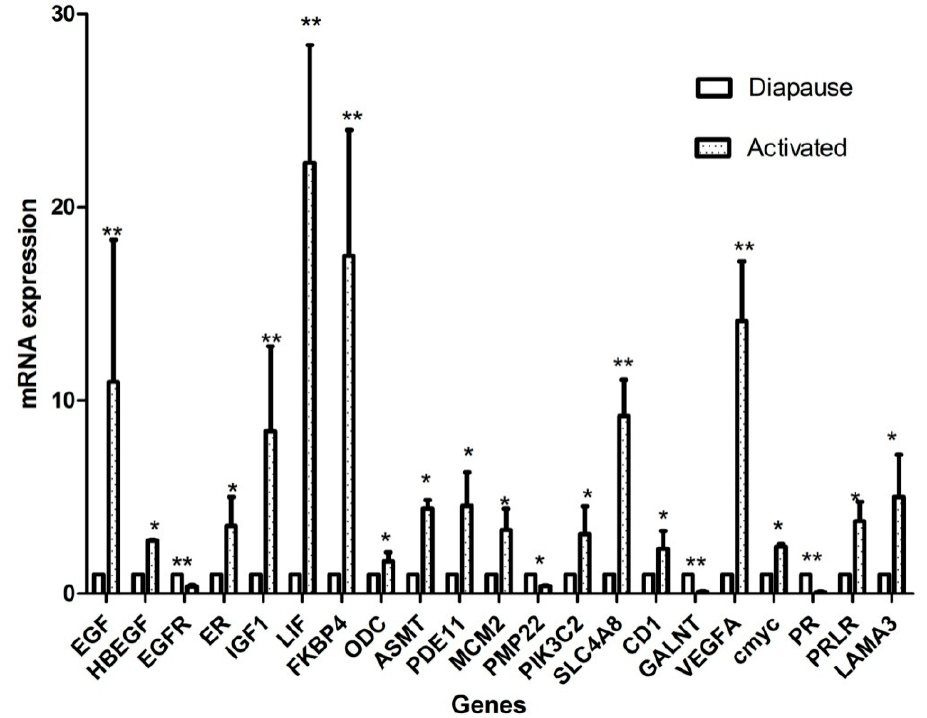
Figure 5. QRT-PCR validation of RNA-Seq data in mink uterus during embryo diapauses and activation: activated/diapause expression ratios. GAPDH was used as the internal control for mRNA analysis. The data shown are from three biological replicates. * p < 0.05, ** p < 0.01.